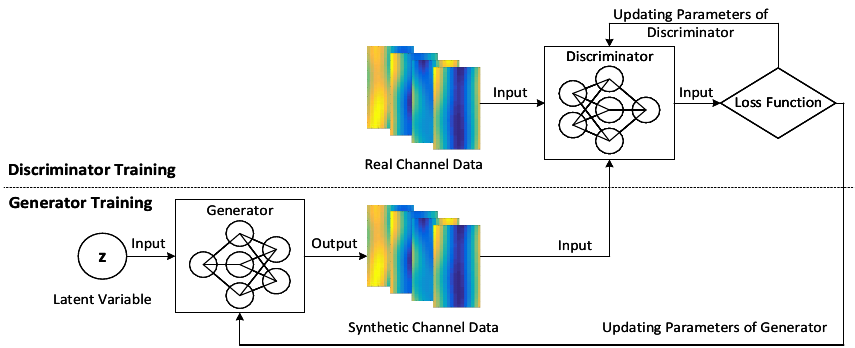
Figure 4. Training procedure of a GAN model.